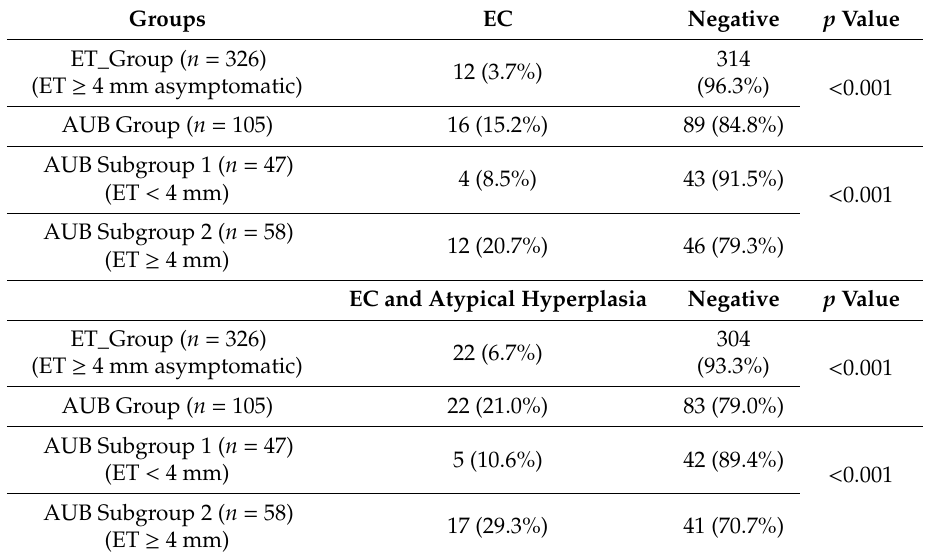
Table 3. Prevalence of endometrial cancer and atypical hyperplasia according to Groups. Groups EC Negative p